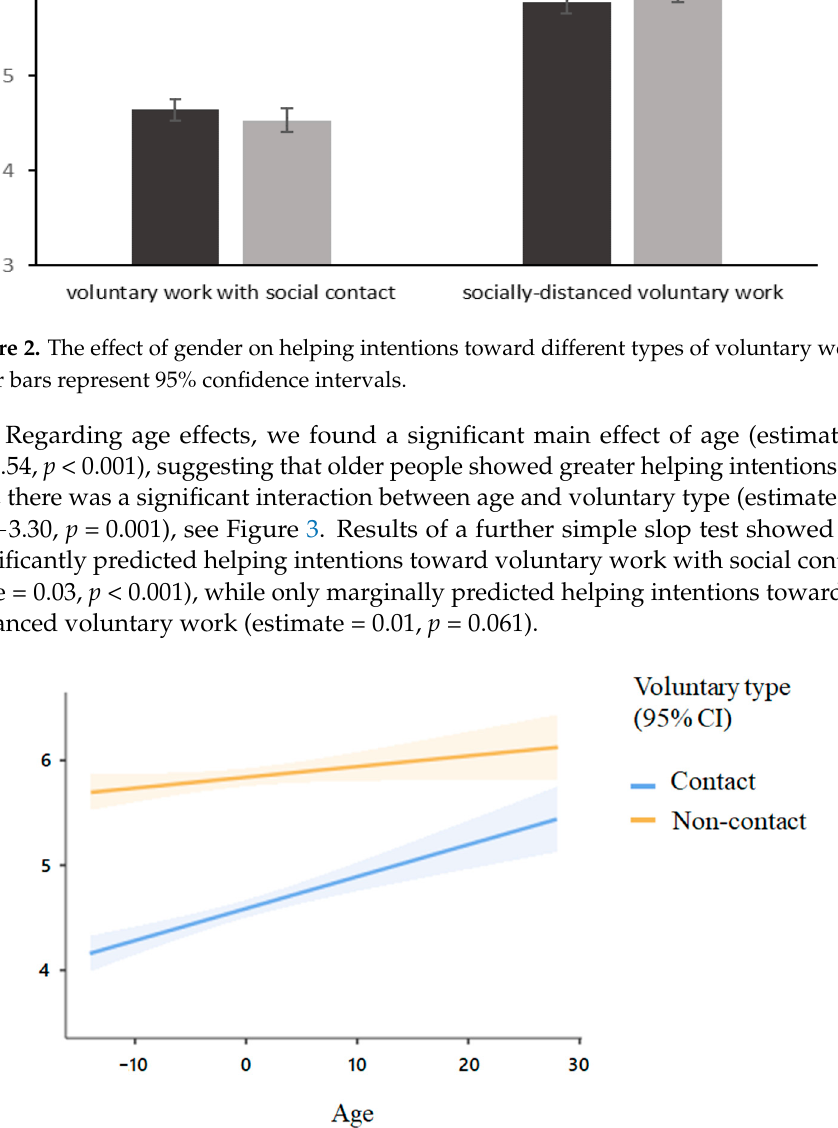
Figure 3. The effect of age on helping intentions toward different types of voluntary work. Note. Shadows represent 95% confidence intervals.